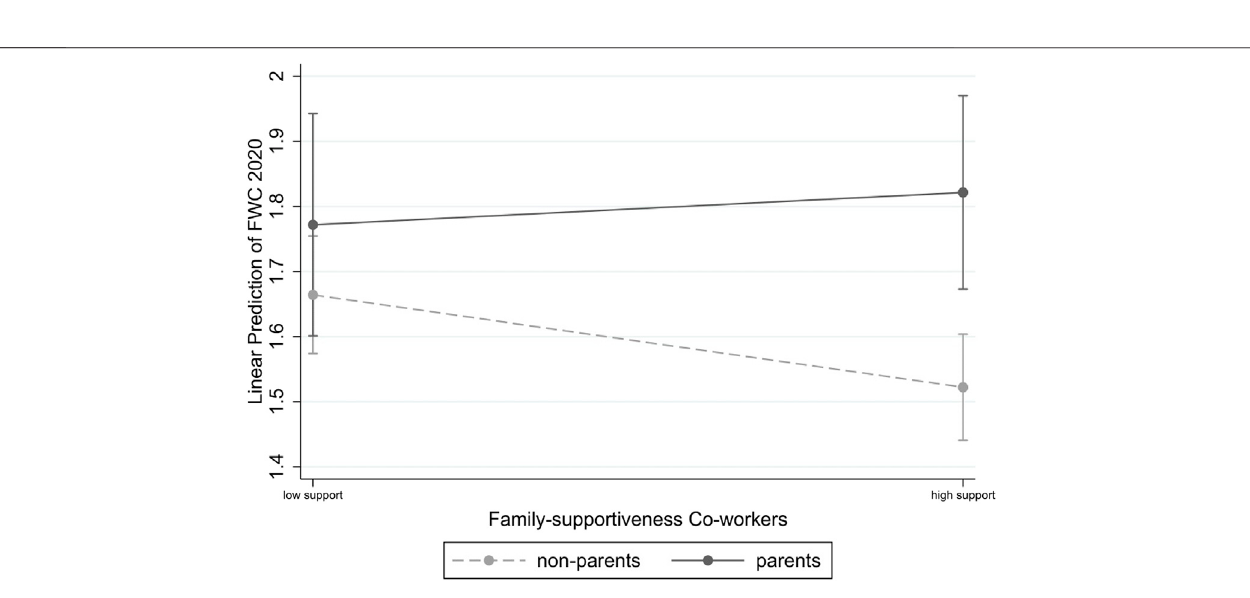
Frontiers in Sociology |